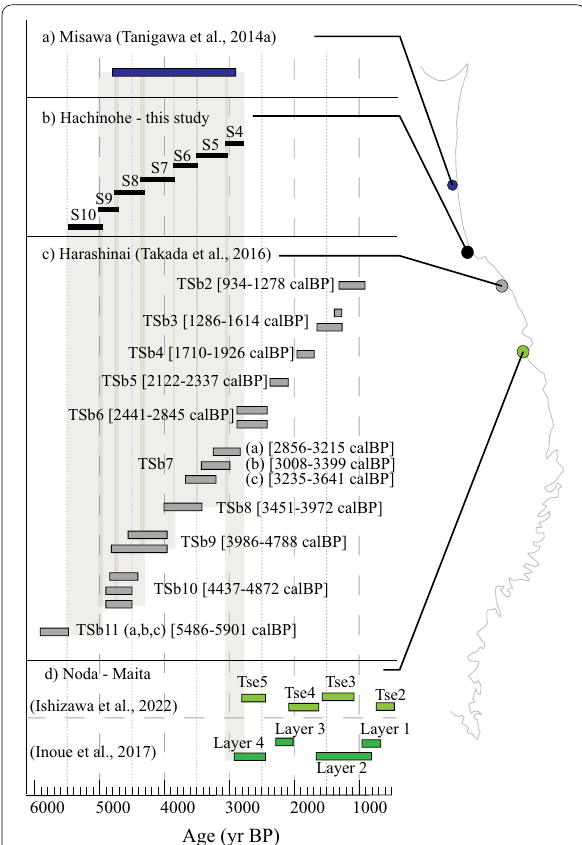
Fig. 15 Chronological correlation with previous studies conducted close to Hachinohe area. a Tanigawa et al. (2014a) in Misawa, northern Aomori; b This study; c Takada et al. (2016) in Harashinai site, TSd stands for tsunami sand; d Ishizawa et al. (2022) and Inoue et al. (2017) in Noda. The position of each survey is plotted in the coastline of the Tohoku